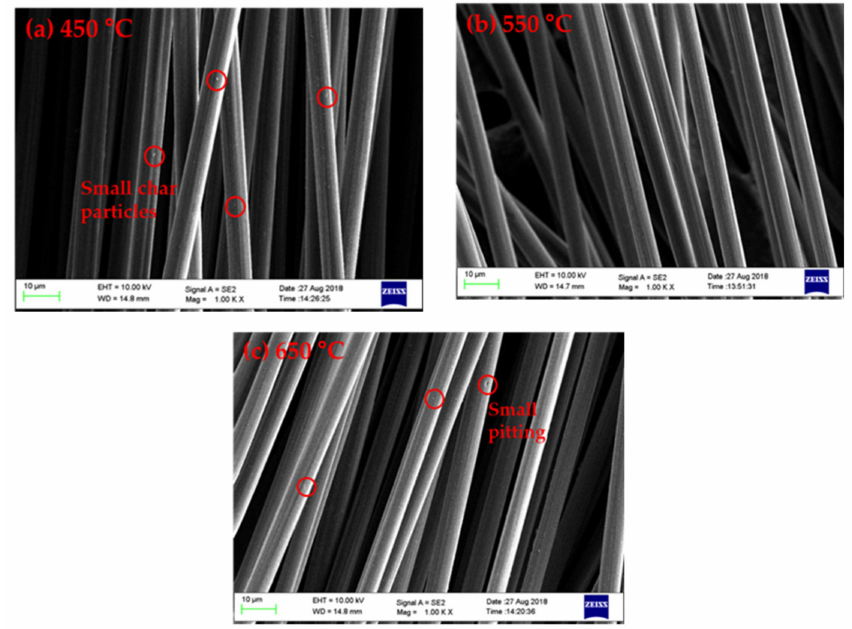
Figure 5. The surface morphology of recycled carbon fibre after oxidation. Fibres were first microwave- pyrolyzed at: ( a ) 450 ◦ C; ( b ) 550 ◦ C; and ( c ) 650 ◦